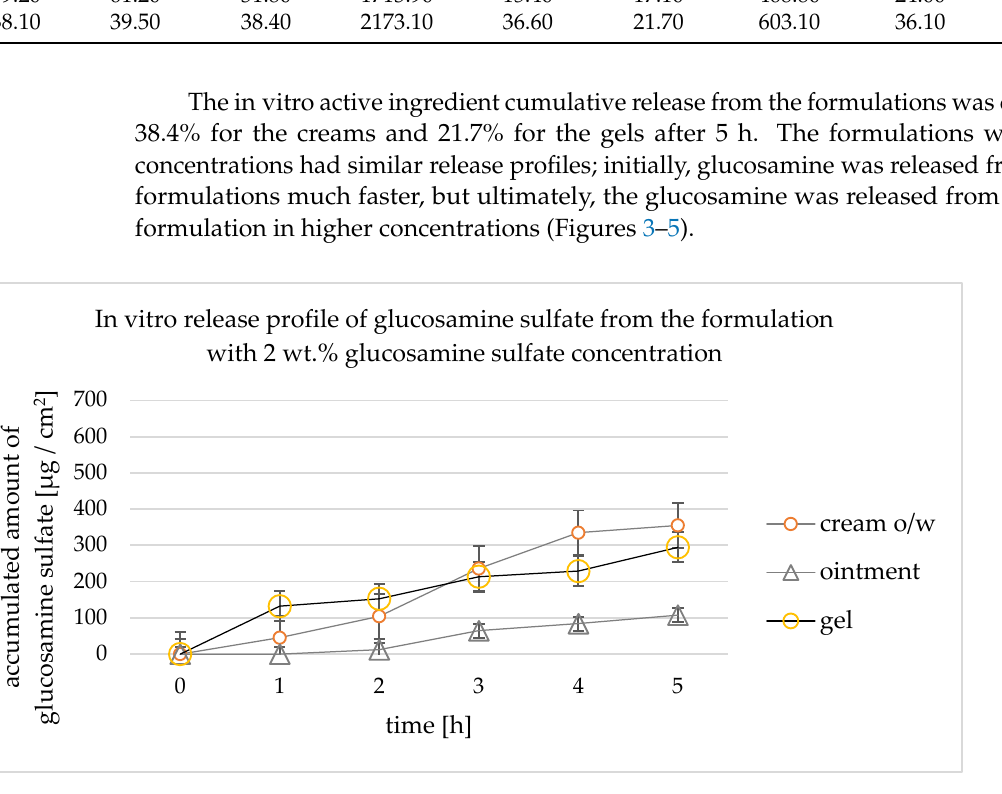
Figure 3. Accumulated amount of glucosamine sulfate—in vitro release study for the formulation with 2 wt.% of glucosamine.